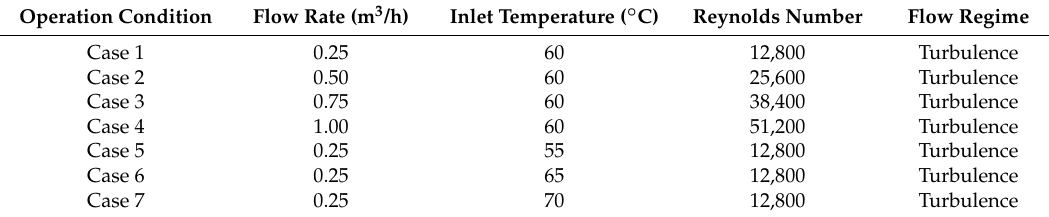
Table 3. Operation conditions of the HTF.